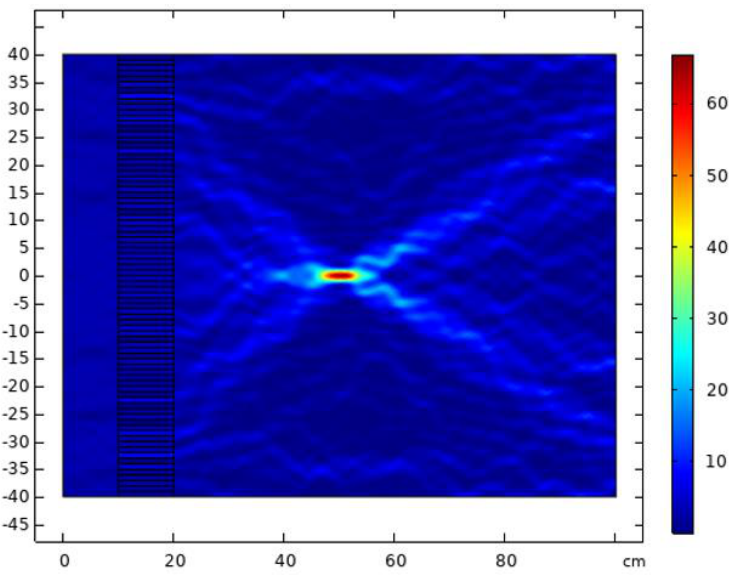
Figure 8. Spatial distribution of acoustic intensity field through focusing lens at 20 kHz.